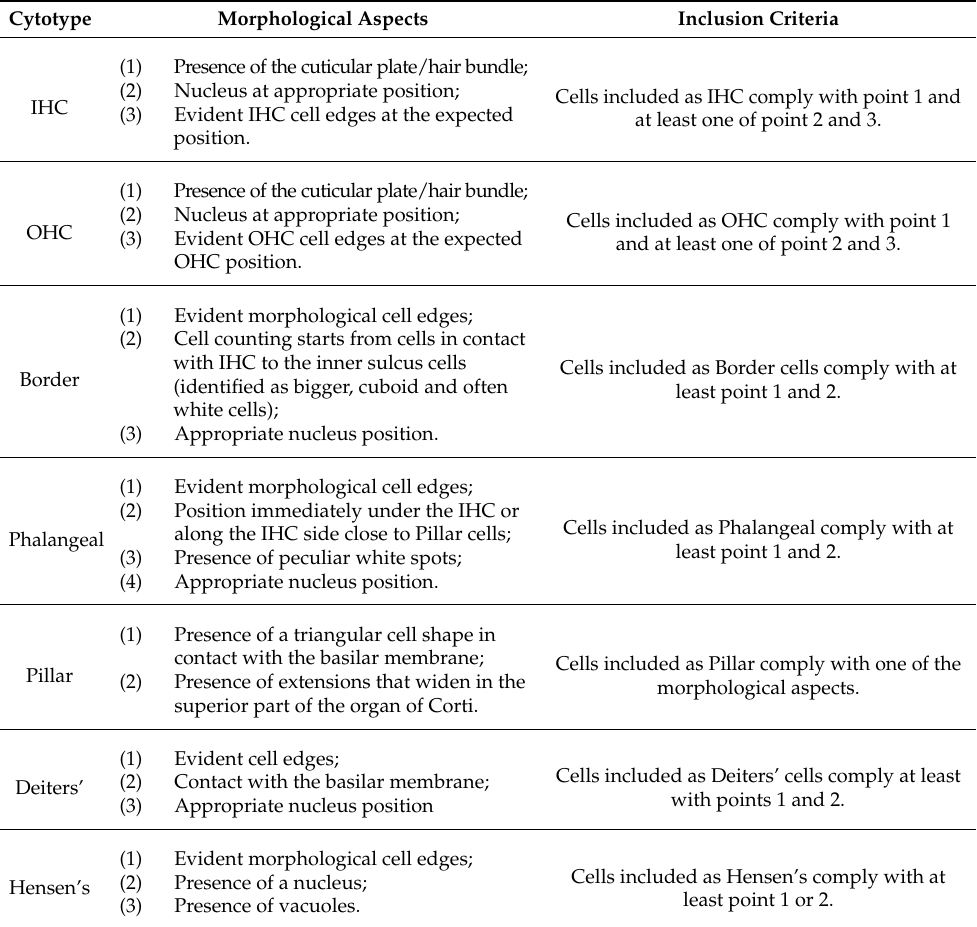
Table 1. Criteria for the identification of specific sensory and non-sensory cells of the organ of Corti. For each cell type, morphological aspects for their identification were determined and used to perform the cell count along the cochlear